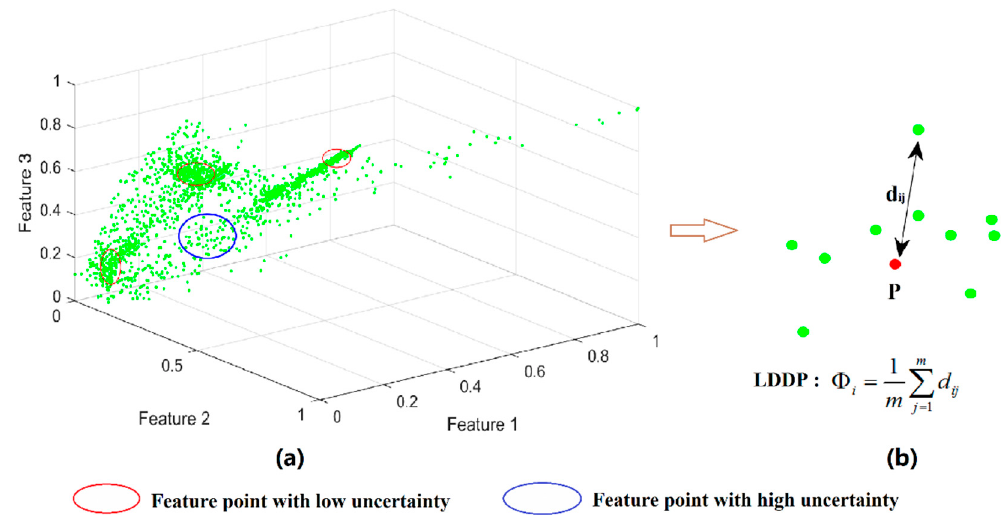
Figure 3. Distribution of di ff erent types of pixels (feature points) in the feature space. LDDP, Local Distribution Density of Points. ( a ) a feature space that corresponds to a real RS image; ( b ) an example for calculating LDDP of pixel